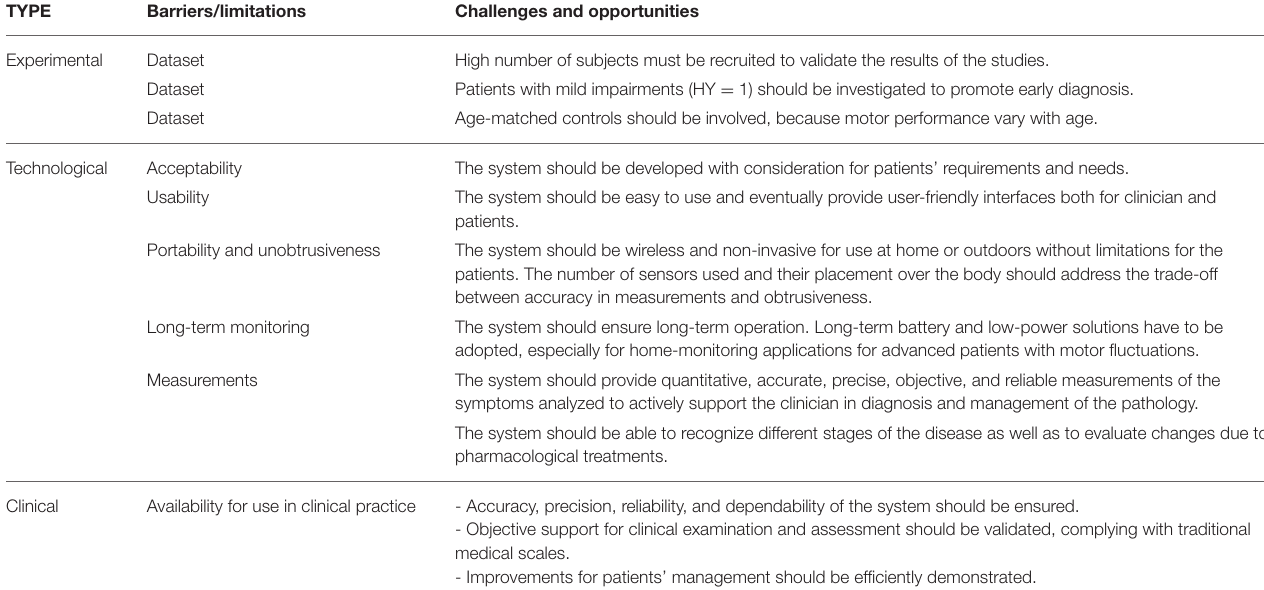
TABLE 10 | Limitations and